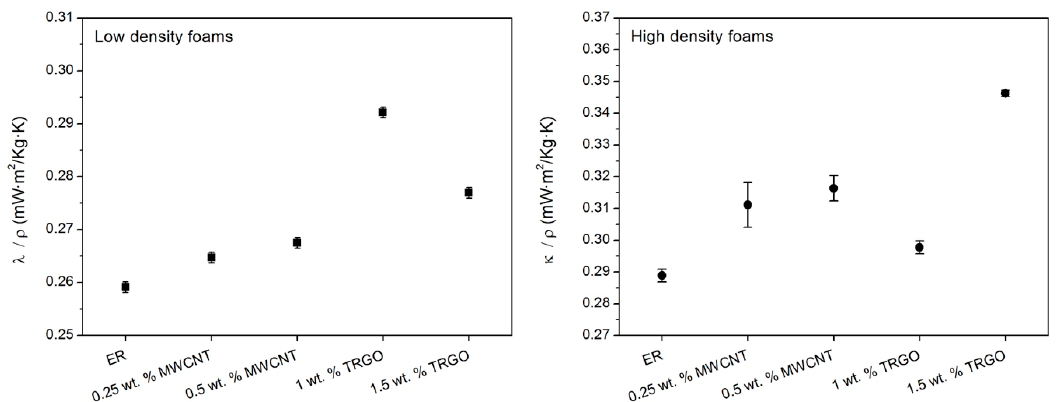
Figure 7. Specific thermal conductivity of ( left ) LD foams and ( right ) HD foams.